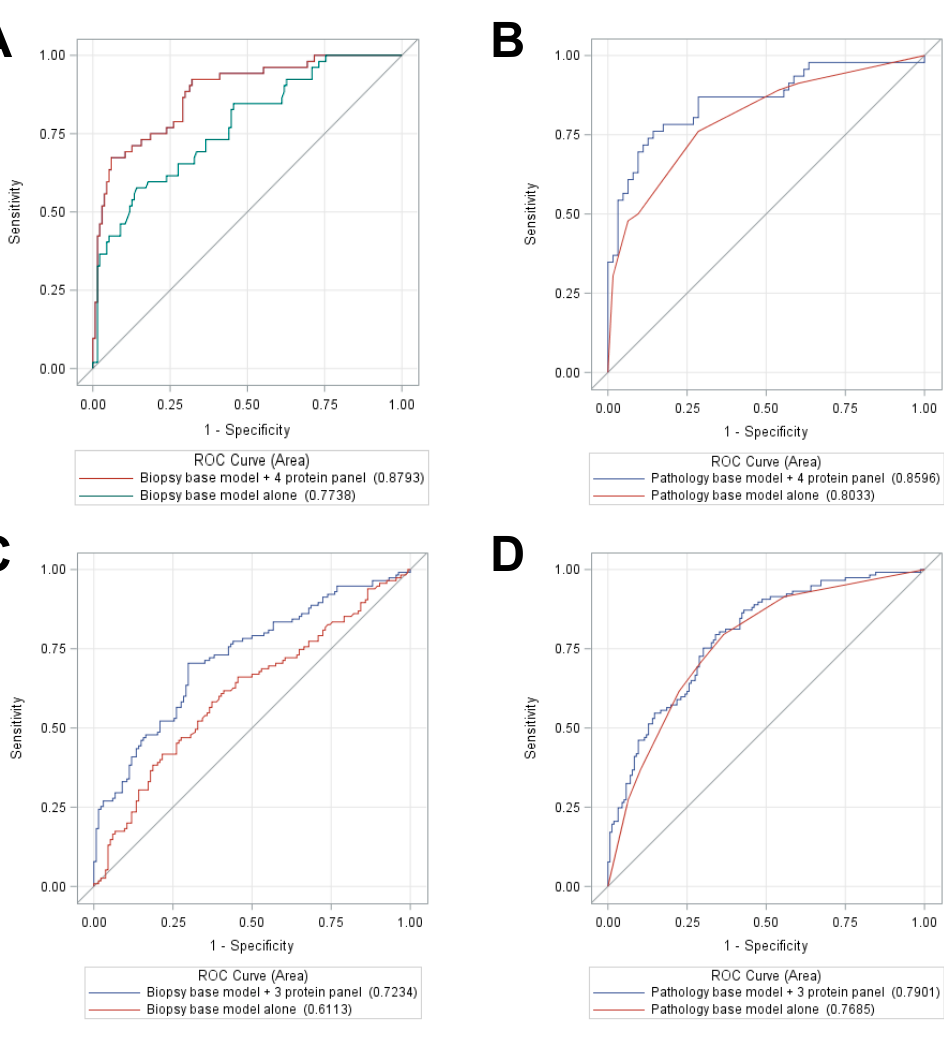
Figure 1. Receiver-operating characteristic (ROC) curves predicting DM or BCR using Standard of Care (SOC) base models and the protein panels versus SOC base models alone: ROC curve analyses for DM with comparison of AUC values for biopsy and pathology SOC base models alone versus in combination with the 4-protein marker panel are shown in A and B , respectively. Similar analyses for BCR are shown in C and D .